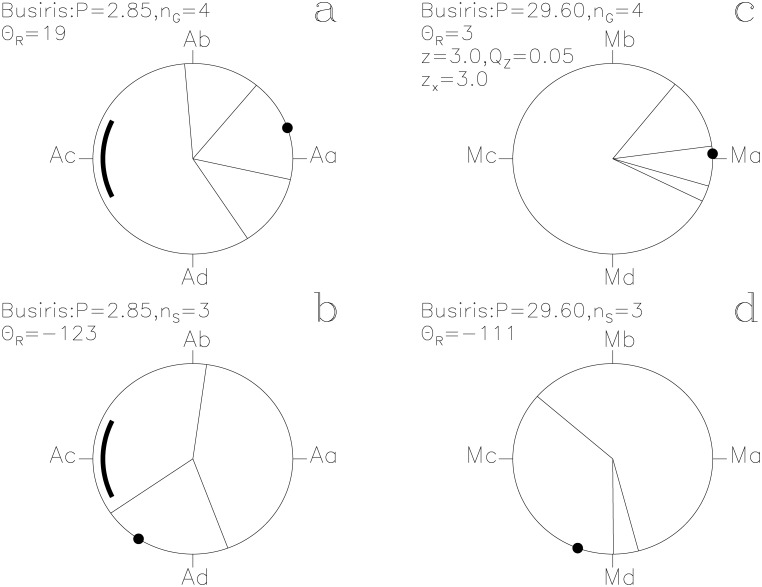
Busiris.otherwise as in Fig 1